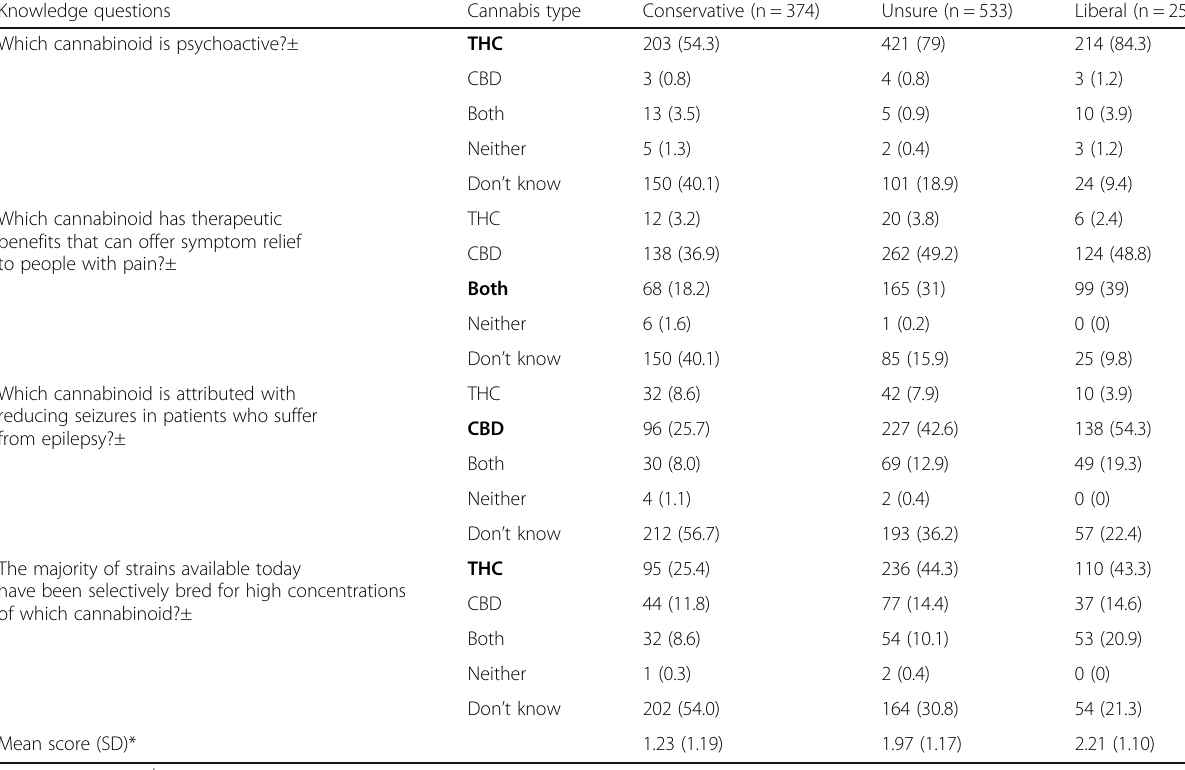
Table 3 Knowledge about cannabis in 1161 adult athletes by attitudes cluster. Correct answers are bolded [Data as N (%)] Knowledge